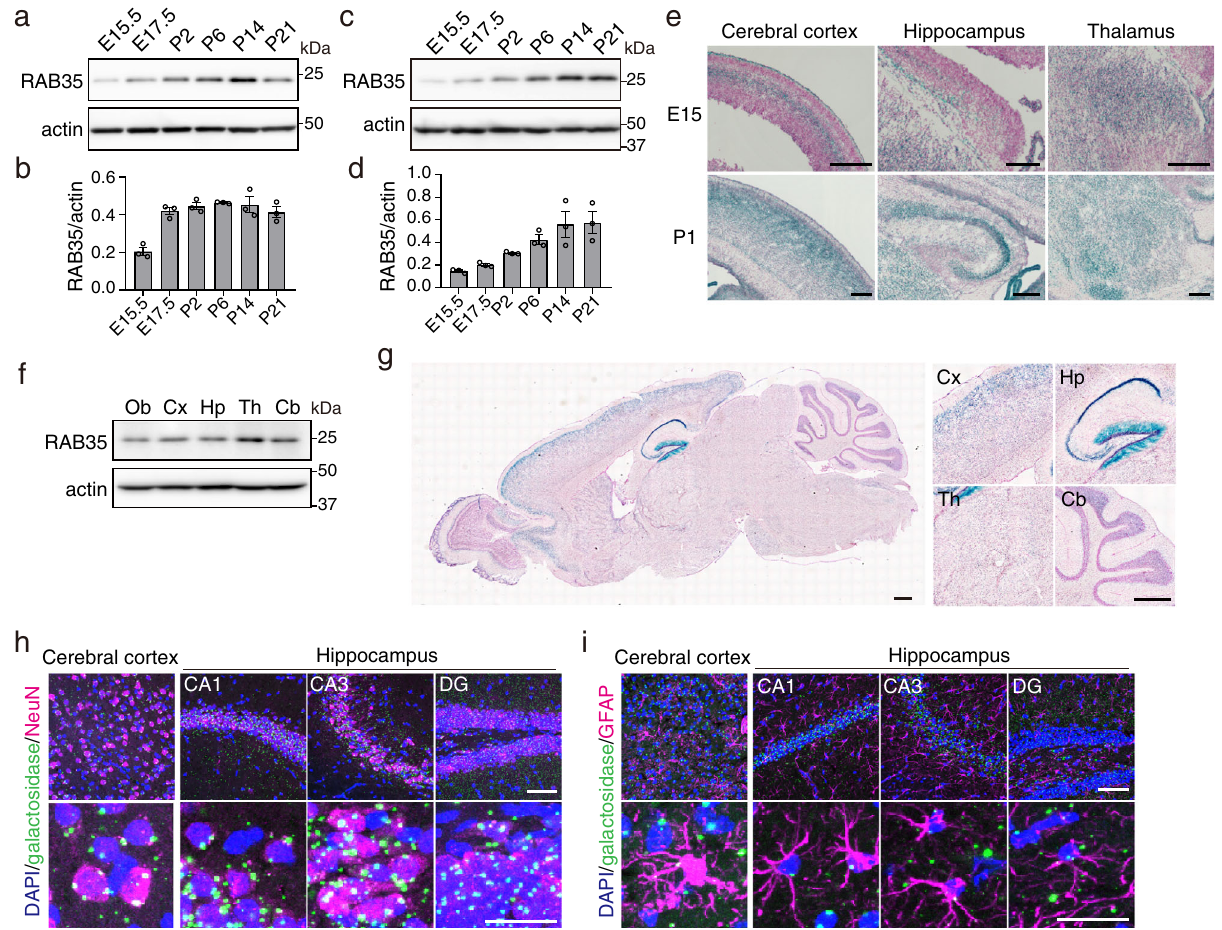
Fig. 1 Expression pro fi le of RAB35 in the mouse brain. a RAB35 protein levels in the whole mouse brain during the embryonic (E15.5 and E17.5) and postnatal (P2, P6, P14, and P21) periods. b Quanti fi cation of RAB35 protein levels in the whole mouse brain. Band intensities of RAB35 were normalized against those of actin ( n = 3 per the indicated stage). c RAB35 protein levels in the hippocampus during the embryonic (E15.5 and E17.5) and postnatal (P2, P6, P14, and P21) periods. d Quanti fi cation of RAB35 protein levels in the mouse hippocampus ( n = 3 per stage). e X-gal staining of sagittal sections from E15 and P1 Rab35 geo/ + mouse brains. Scale bars, 200 μ m. f RAB35 protein levels in 3-month-old mouse brain subregions. Ob olfactory bulb, Cx cerebral cortex, Hp hippocampus, Th thalamus, Cb cerebellum. g X-gal staining of a sagittal section of a 3-month-old Rab35 geo/ + mouse brain. Scale bars, 500 μ m. h , i Representative maximum intensity projection images of 4-month-old Rab35 geo/ + mouse brain stained for β -galactosidase (green), NeuN or GFAP (magenta), and DAPI (blue). Scale bar; upper panel, 50 μ m; lower panel, 20 μ m. Data represent mean ±